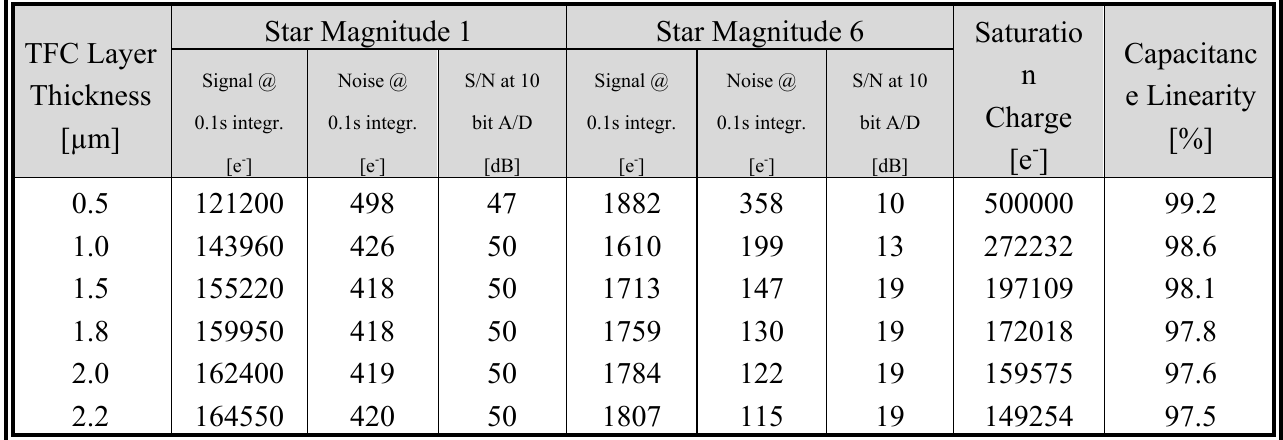
Table 1. Simulation results of the TFC layer